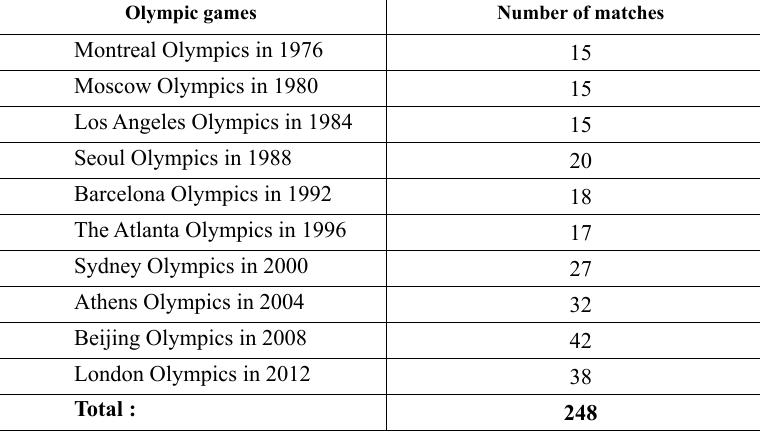
Table 1. The data samples